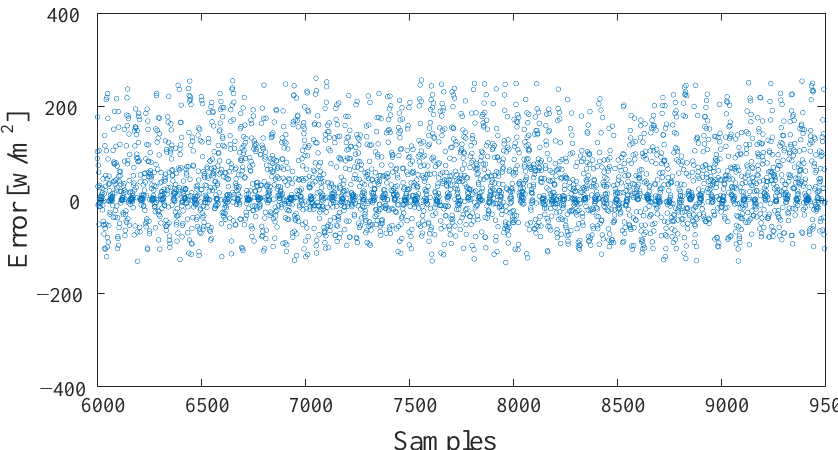
Figure 13. The predicted samples of the proposed method compared to the actual values of GHI. The samples are recorded every 15 min.